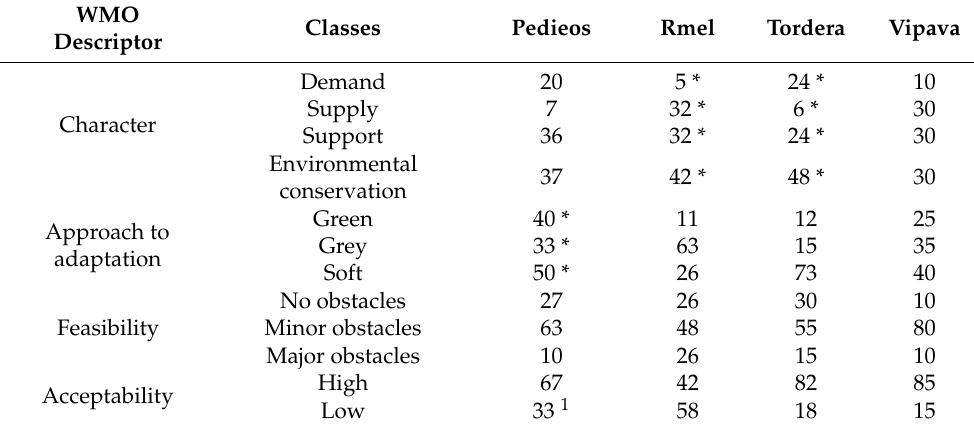
Table 4. Percentage of WMOs per river basin corresponding to each descriptor class for character, approach, feasibility, and acceptability. For some descriptors, more than one class could be chosen per water management option; thus, the total % may exceed 100% (these cases are marked with * in the